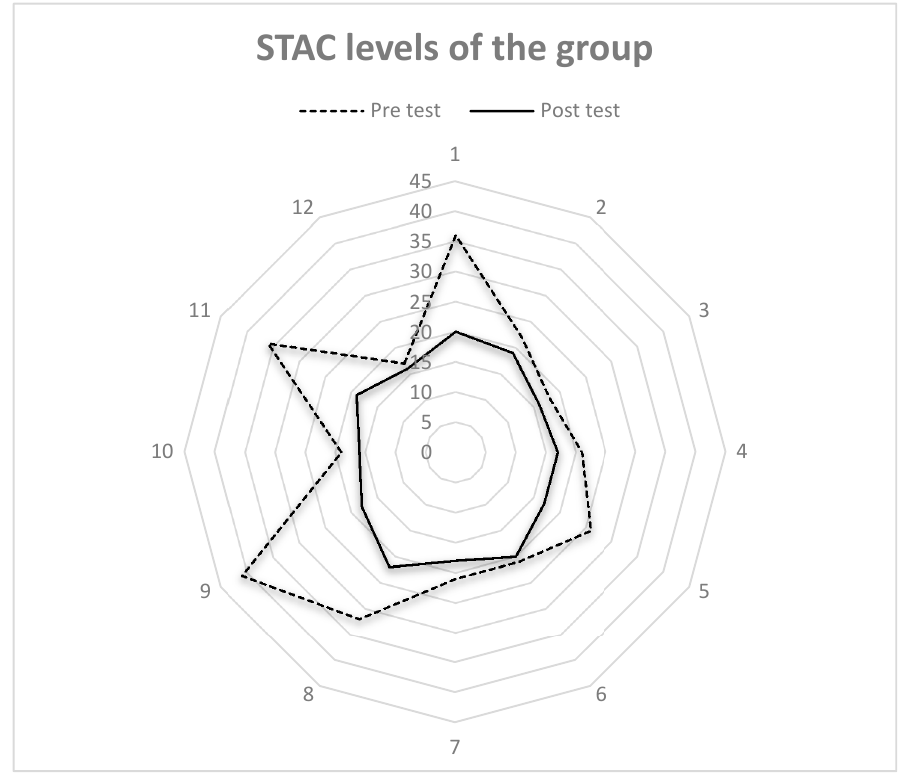
Figure 3. Spiderweb of experimental group subjects’ pre- and post- scores obtained in the FES-I. The personal Body Mass Index data (BMI) has been correlated through the Pearson correlation coefficient, with the results obtained in the measurements made on the fear of falling syndrome (STAC), and no significant statistical differences were found for this variable (pre-test r = 0.962 y con el post-test r = 0.844).